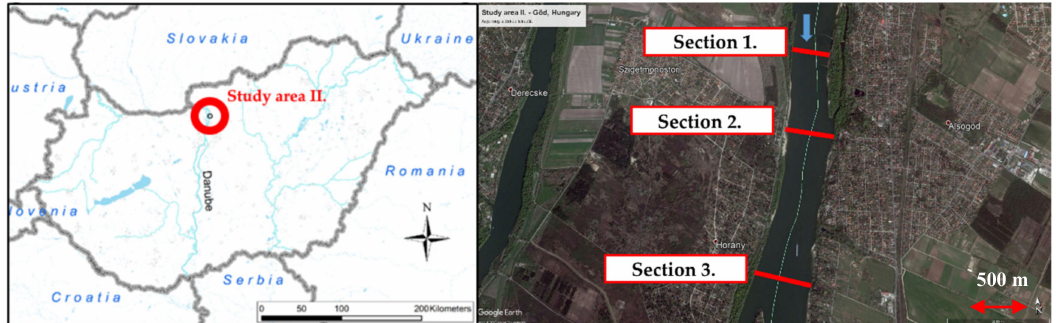
Figure 2. Study area II: Göd, Hungary, River Danube (between rkm 1669.4 and rkm 1667.2). Cross-sectional ADCP (Acoustic Doppler Current Profiler) and video measurements (moving boat measurements) were carried out in the sections marked with red.